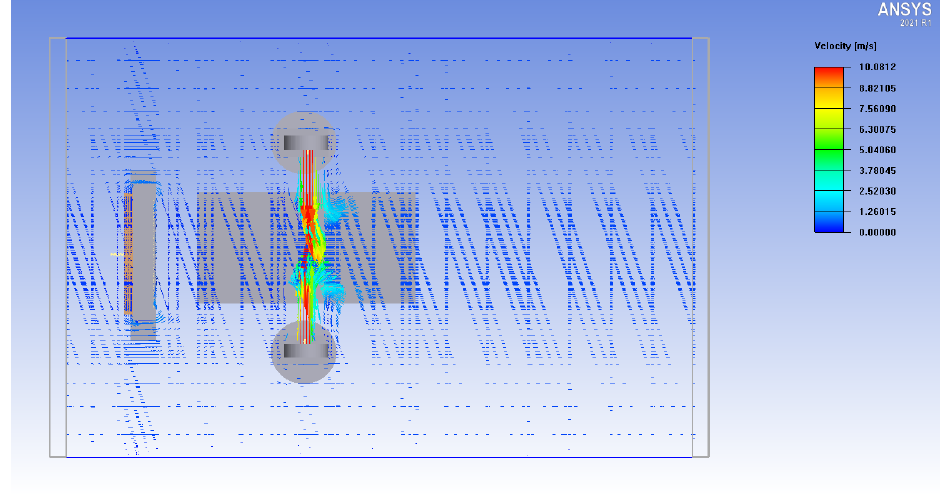
Figure 26. Air purifier top-view simulation in the quarantine station at a high rotation speed.